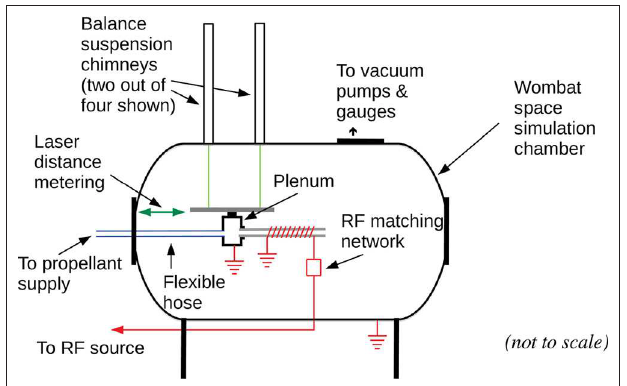
FIGURE 3 | A simplified sketch of the inductive PR, shown here installed in the Wombat vacuum chamber equipped with a thrust balance.